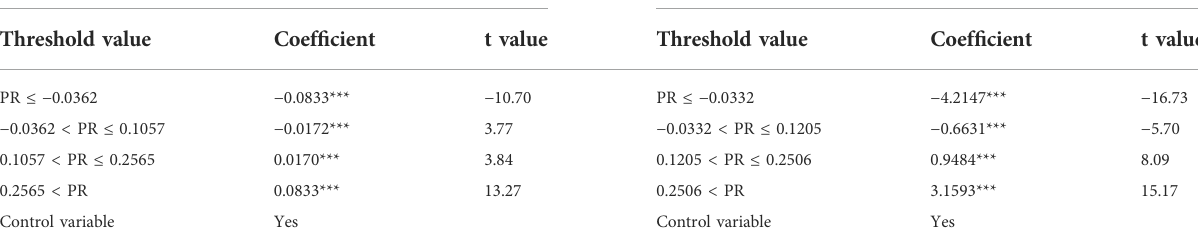
TABLE 6 Results of threshold regression.